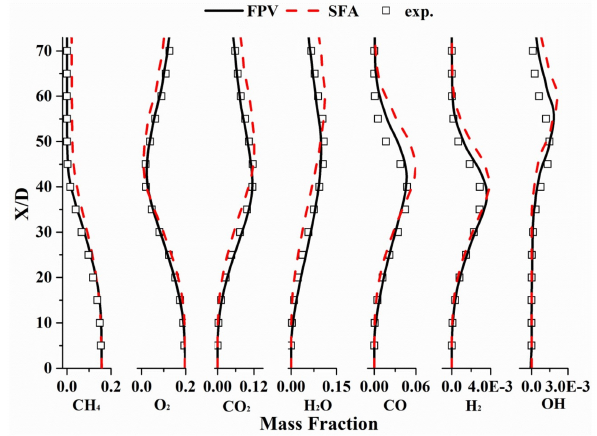
Figure 8. Favre-averaged species mass fractions along the